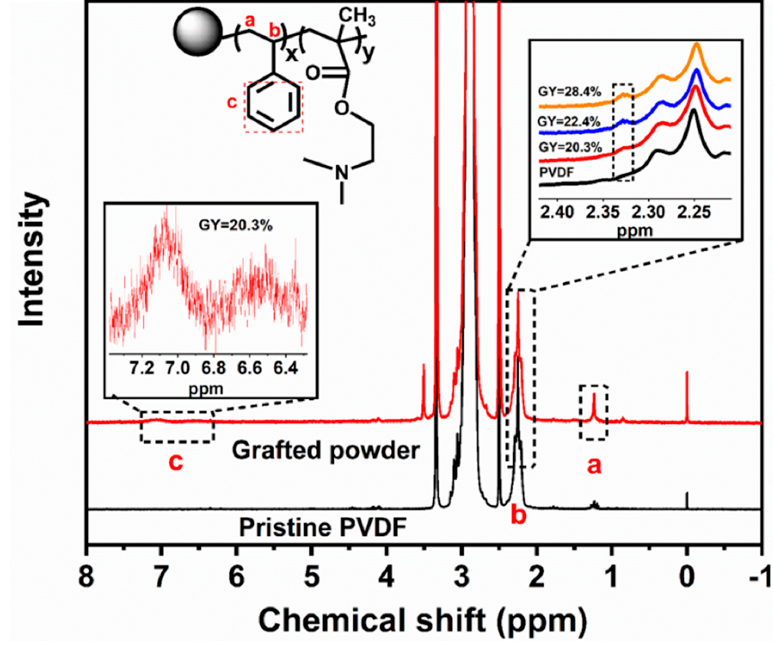
Figure 3. 1 H-NMR spectra of pristine PVDF and grafted powder with different GYs.